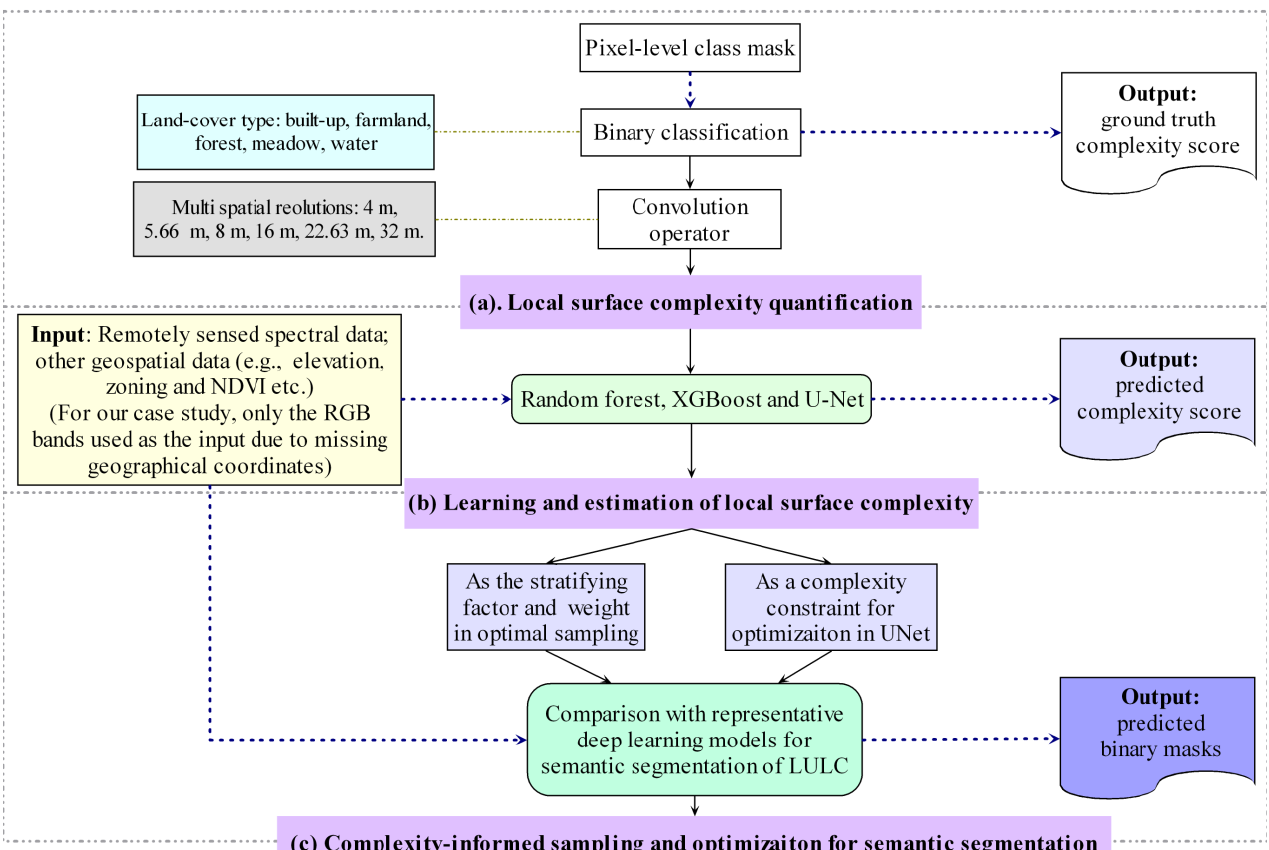
Figure 3. Flow chart for local surface complexity quantification ( a ), learning ( b ), and optimal sampling and constraint ( c ) for binary semantic segmentation.